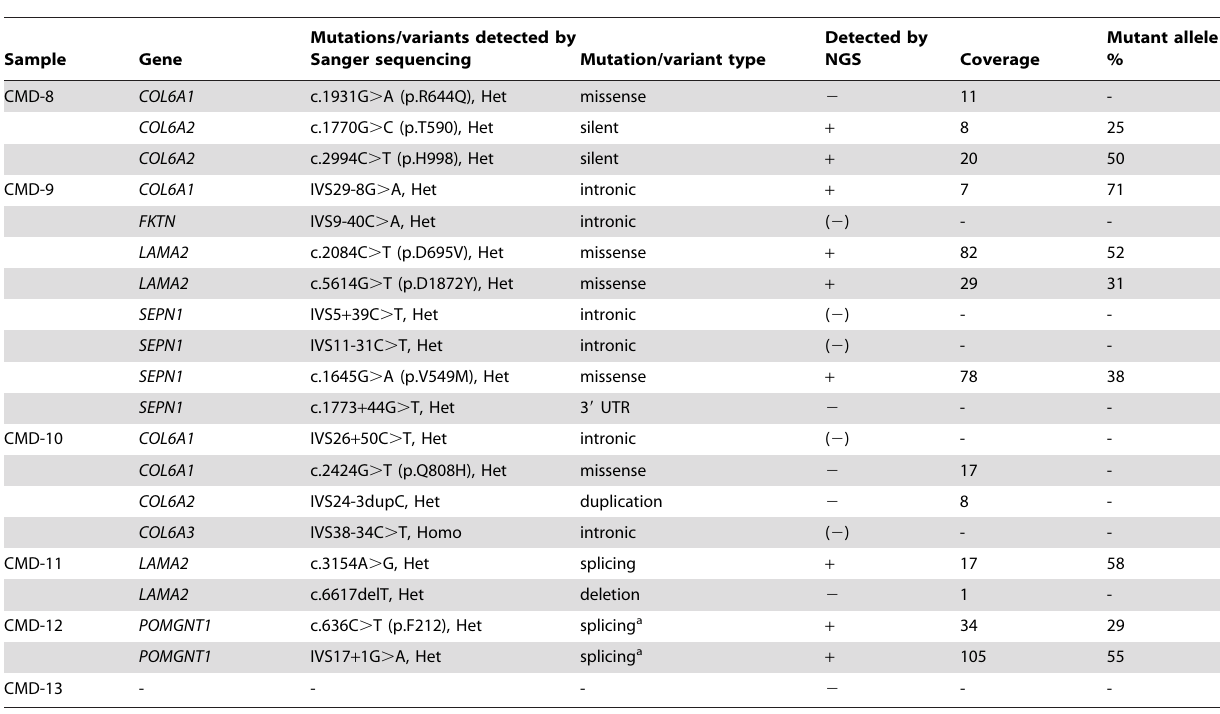
Table 4. Validation of NGS for variant/mutation detection on known CMD-positives samples.